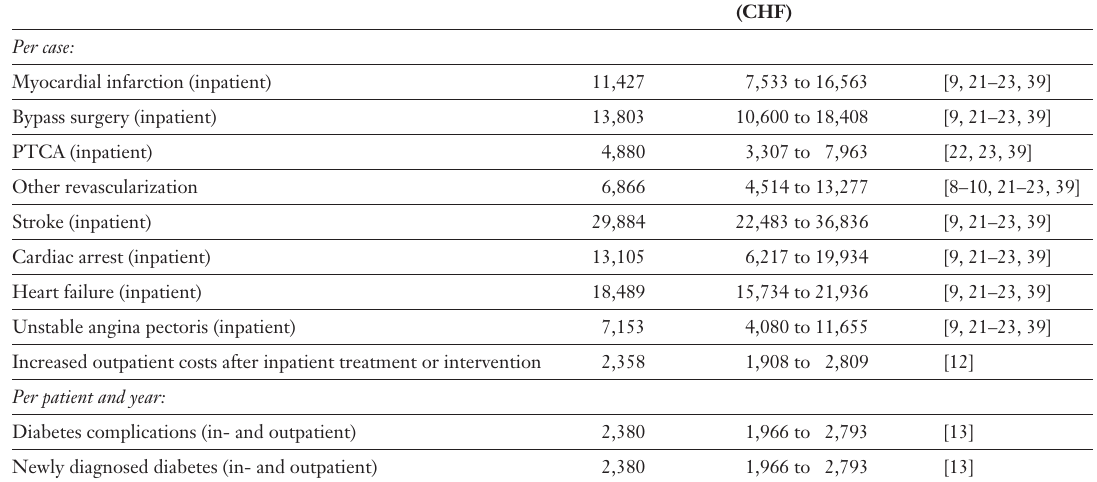
Table 1 Cost to Swiss health insurers for treating target